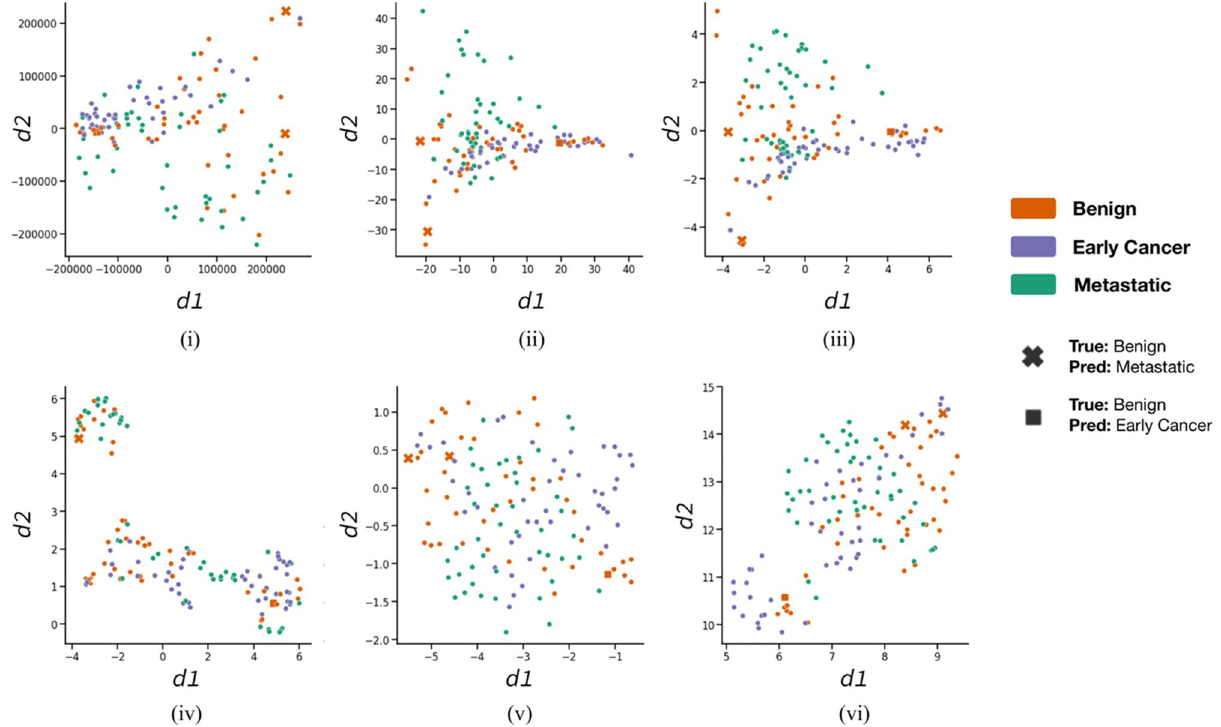
Figure 6. Dimensionality reduction of spectra to 2D using (i-iii) PCA and (iv-vi) UMAP algorithms. Results are illustrated for three independent spectra scaling approaches, applied prior to dimensionality reduction: (i, iv) no additional scaling, (ii, v) standardisation of each m/z peak position to mean = 0, standard deviation = 1 across the n = 135 dataset, and (iii, vi) min–max scaling where each m/z peak position is scaled to a fixed [0,1] domain. In each subplot, each scatter point corresponds to an individual sample in the n = 135 dataset, coloured by cancer diagnosis state. The three benign samples that were misclassified by the MLP model as “metastatic” and “early cancer” have been highlighted as cross and square markers,